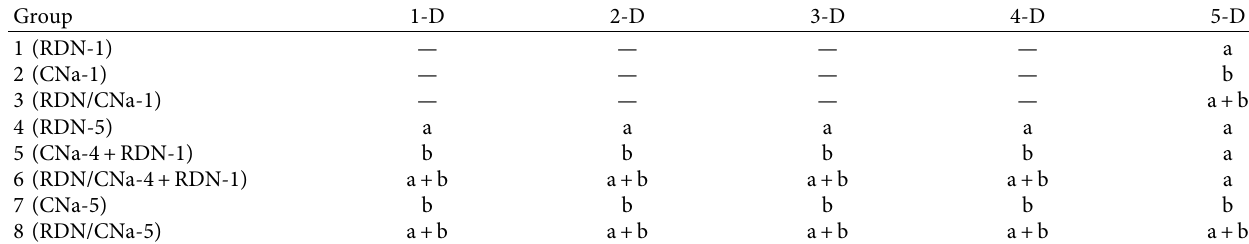
Table 2: The experimental design of pharmacokinetic